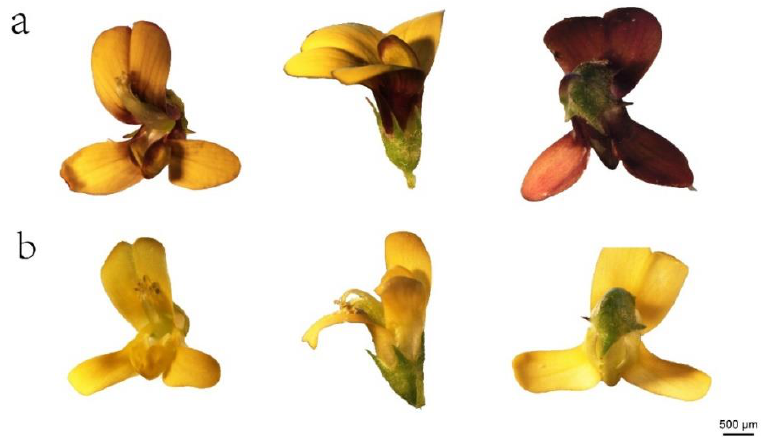
Figure 1. The phenotype observations of the M. ruthenica species. The flower samples were collected from PFM ( a ) and YFM ( b ) during the flowering phase at the same time of day (11–12 am) and stored at 4 ◦ C to keep them fresh; then, the samples were inspected under a stereomicroscope and photographed. Flower face (left), side (middle), and bottom (right) images are shown. During the investigation of M. ruthenica , two distinct flower color phenotypes were observed, with one having the purple-reddish outside and yellow petal inside (PFM) and the other with the purely yellow petal